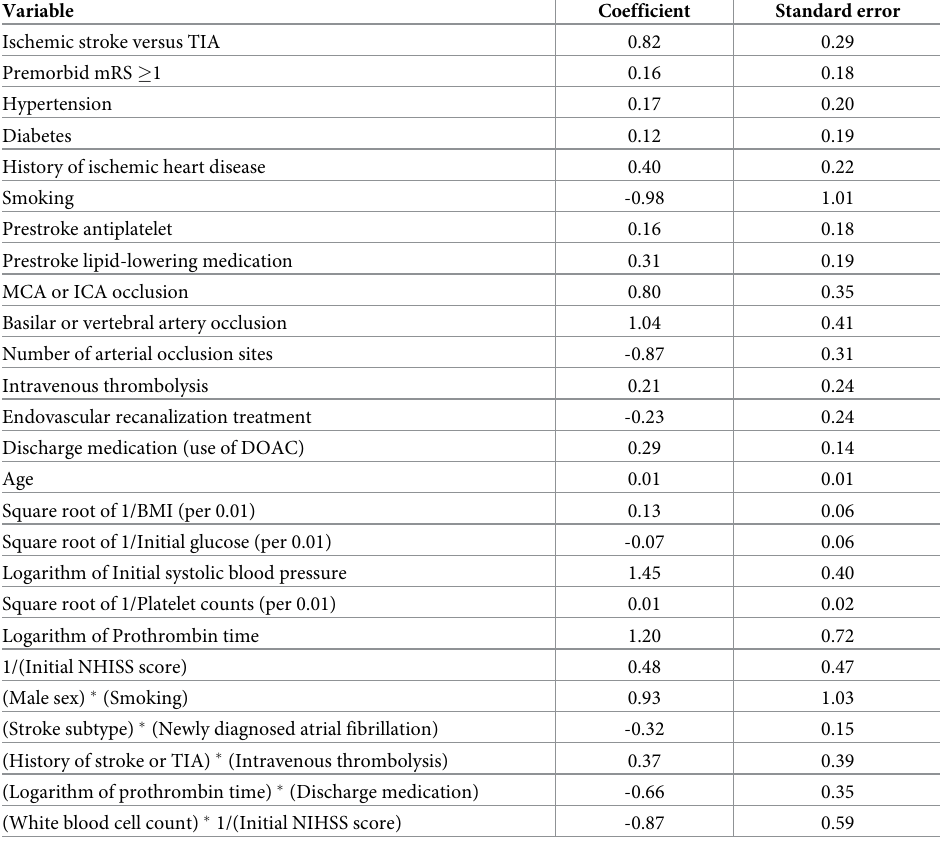
Table 2. Clinical prediction model for recurrent stroke among ischemic stroke patients with documented atrial fibrillation, incorporating the competing risk from all-cause mortality. Variable Coefficient Standard error Ischemic stroke versus TIA 0.82 0.29